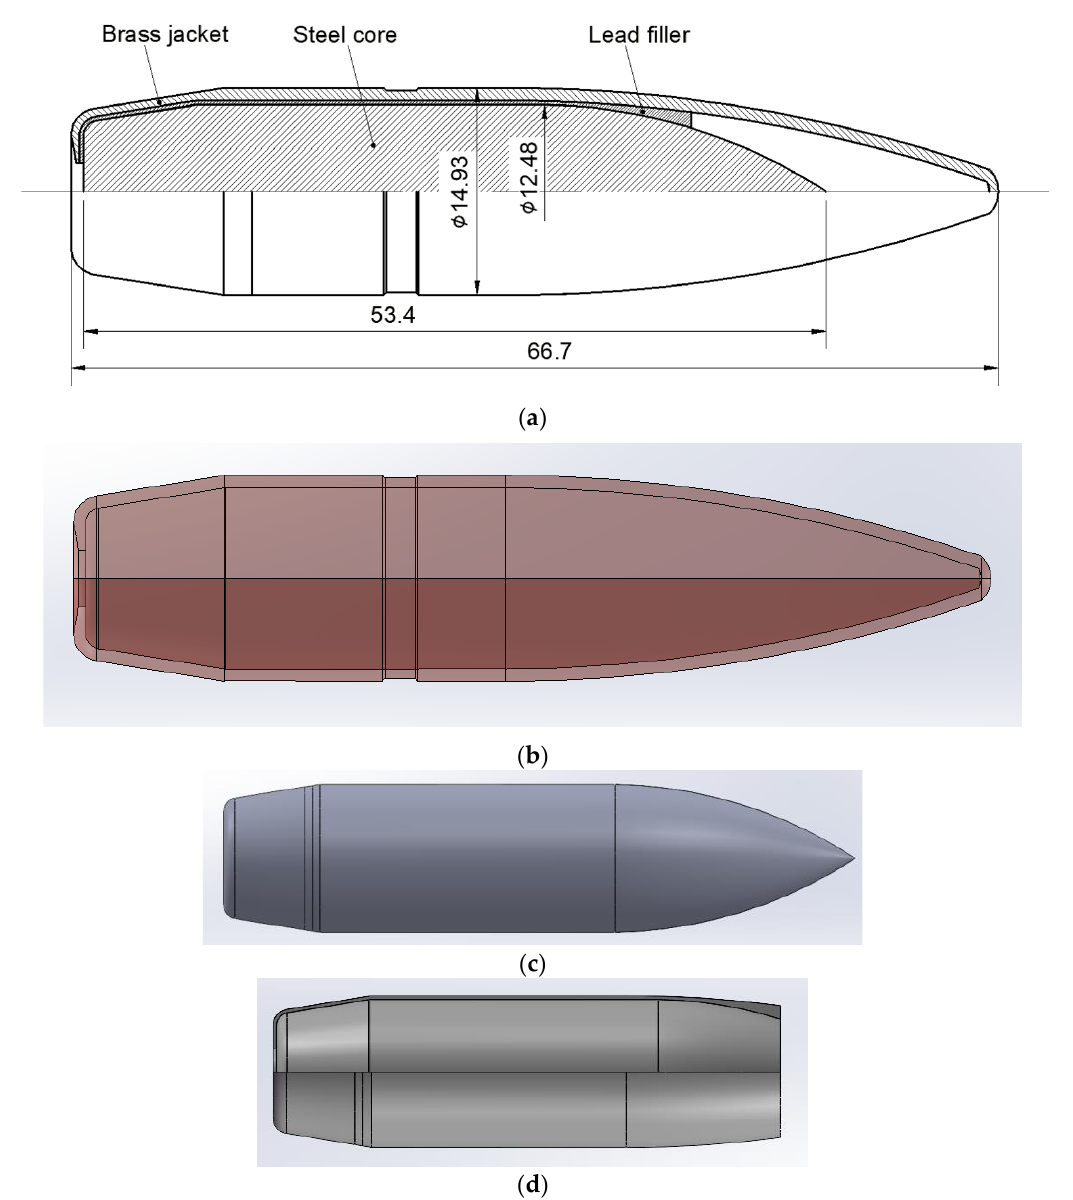
Figure 2. Structure of a 14.5 mm caliber armor – piercing projectile. ( a ) Geometric structure. ( b ) Brass jacket. ( c ) Steel core. ( d ) Lead filler. jacket. ( c ) Steel core. ( d ) Lead